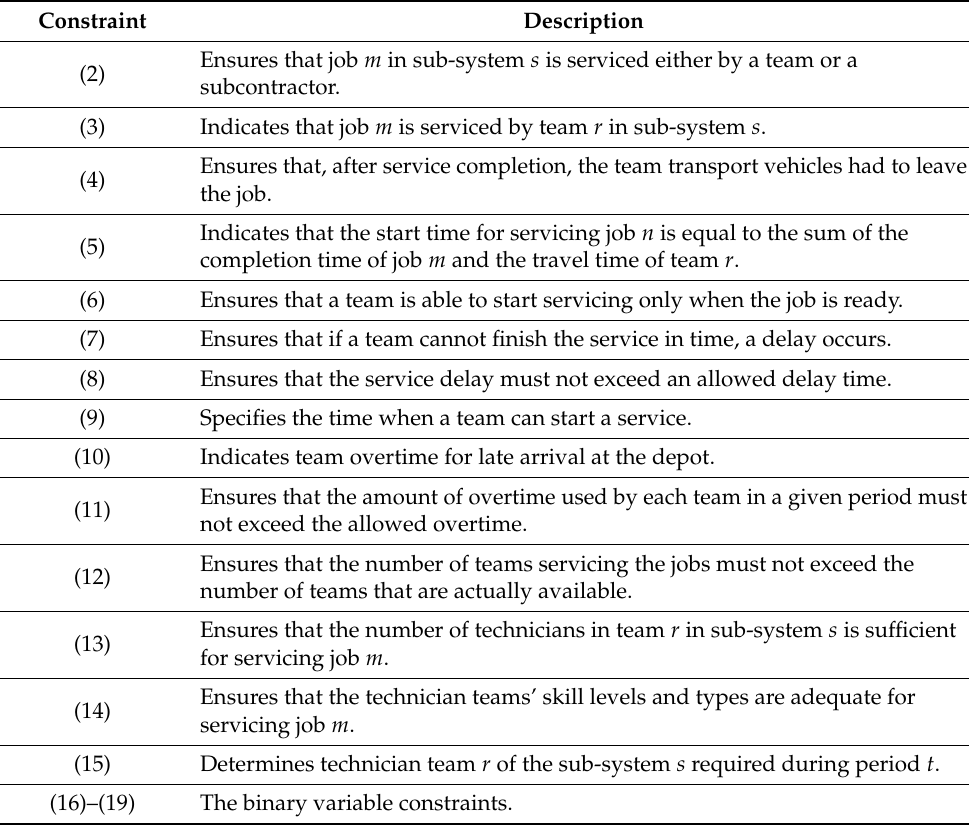
Table 1. Mathematical formulation